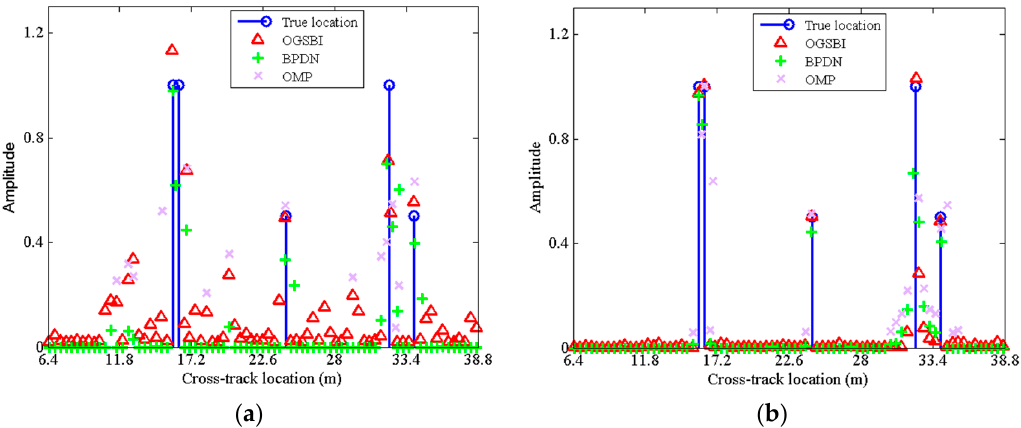
Figure 5. Cross-track 1-D reconstructed profiles by three methods with ( a ) SNR = 5 dB; ( b ) SNR = 25 dB.